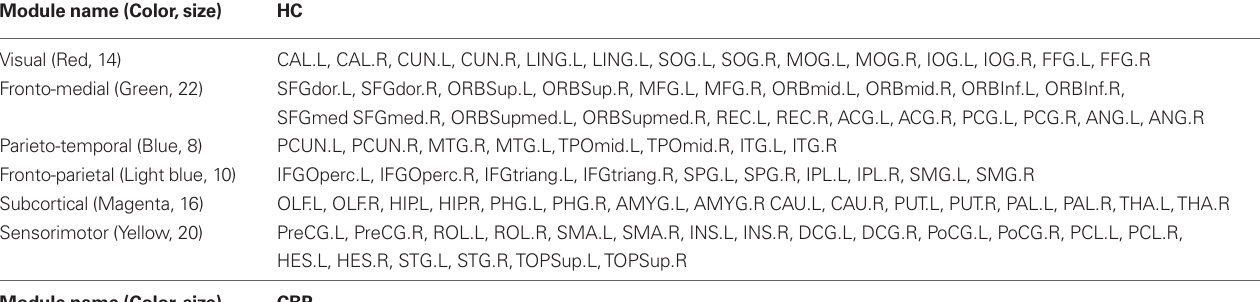
Table A2 | List of regions composing each of the six communities found for the brain networks in each group. Module name (Color, size)